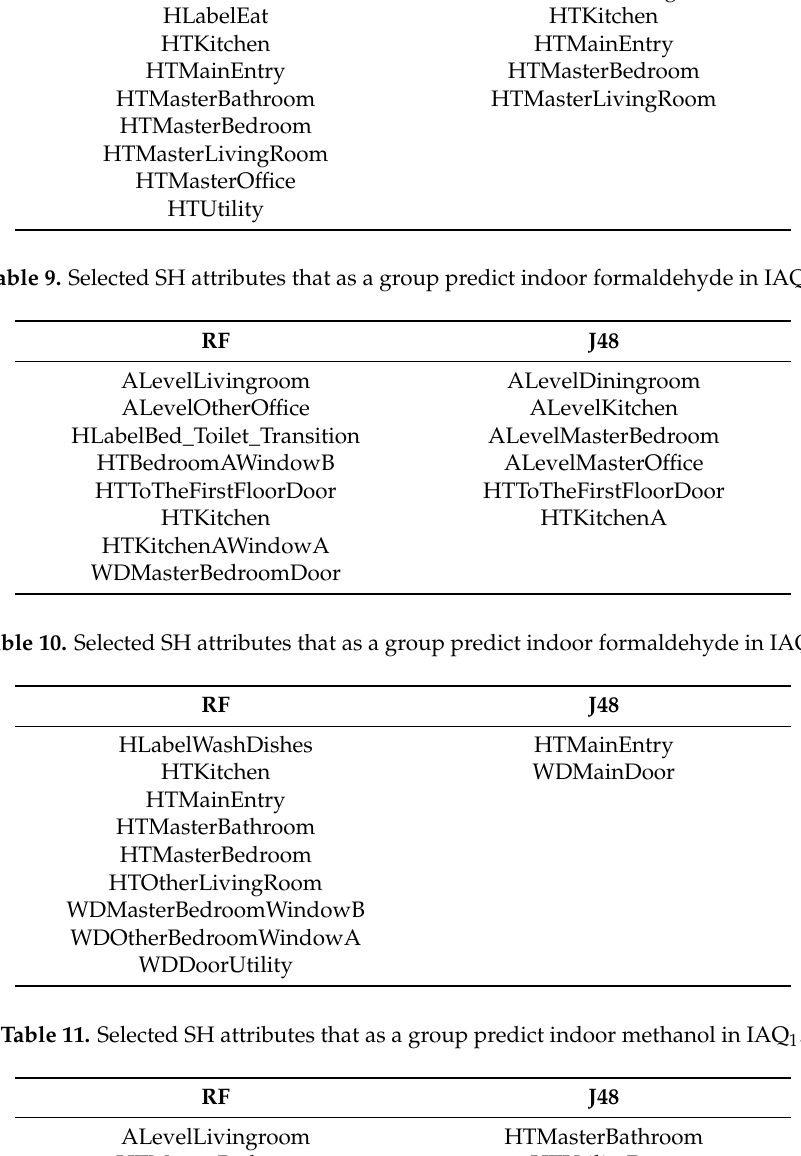
Table 8. Selected SH attributes that as a group predict outdoor PM 2.5 in IAQ 2 .